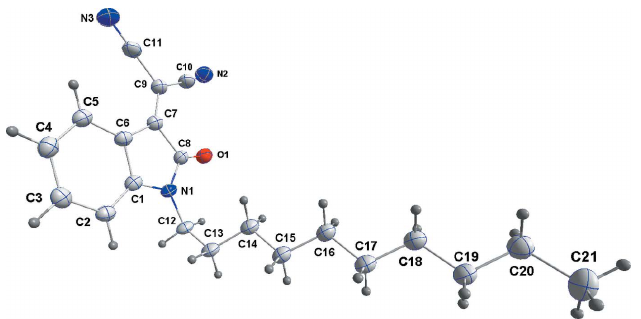
Figure 1 The title molecule with the labelling scheme and 50% probability ellipsoids.